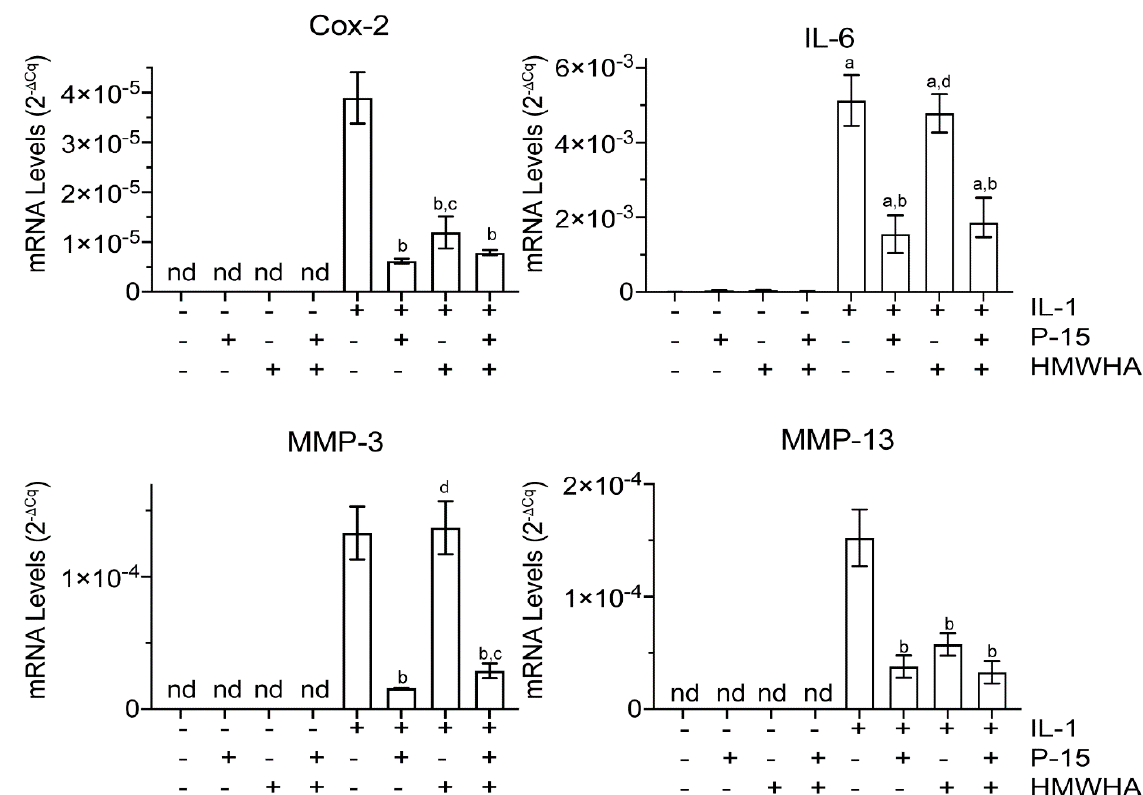
Figure 1. mRNA levels of catabolic markers in vehicle–treated or interleukin–1beta (IL–1 β )-treated human bone–marrow– derived mesenchymal stem cells (BMSCs) cultured in the absence or presence of P15–1 and high–molecular–weight hyaluronan (HMWHA). Human BMSCs were serum–starved for 24 h followed by treatment with vehicle or IL–1 β in the absence or presence of P15–1, HMWHA, or P15–1 and HMWHA for 48 h. The mRNA levels of catabolic markers (Cox–2 and interleukin (IL)–6) and metalloproteinases (MMP–3 and MMP–13) were determined by real–time PCR using SYBR Green and normalized to the level of 18S RNA. Data were obtained from triplicate PCRs using RNA from 3 different cultures. Values are the mean ± standard deviation (SD). a p < 0.01 vs. vehicle–treated cells; b p < 0.01 vs. IL–1 β –treated cells; c p < 0.05 vs. IL-1 β /P15–1–treated cells; d p < 0.01 vs. IL–1 β /P15–1–treated cells; nd, not detected.